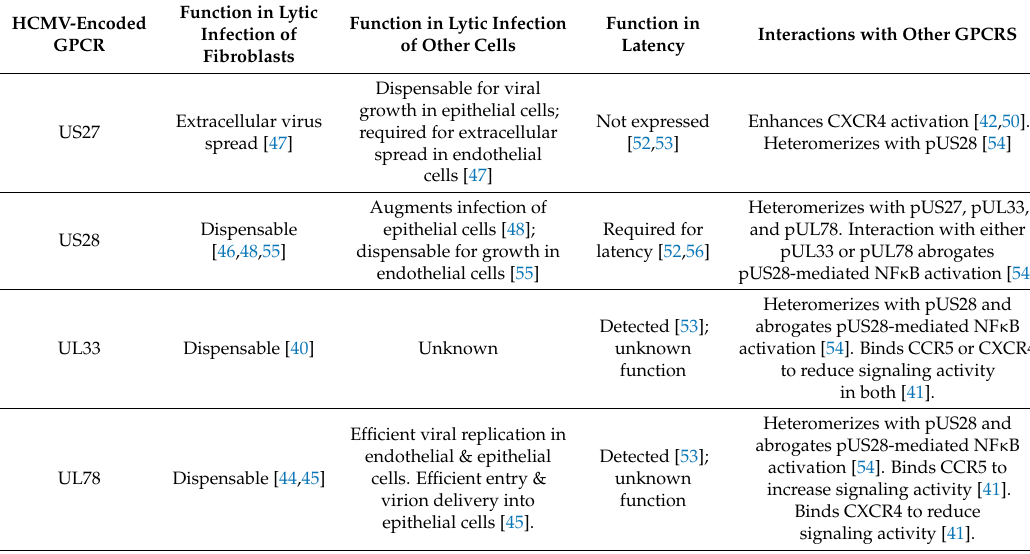
Table 1. Summary of the HCMV-encoded GPCR